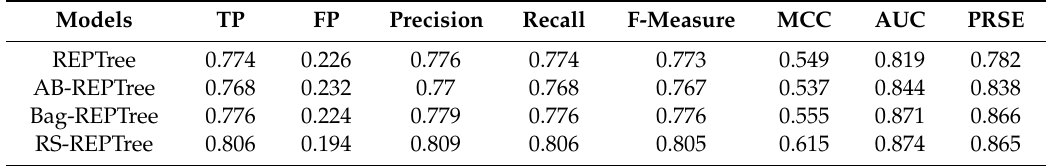
Table 6. Evaluation of gully erosion susceptibility models using machine learning